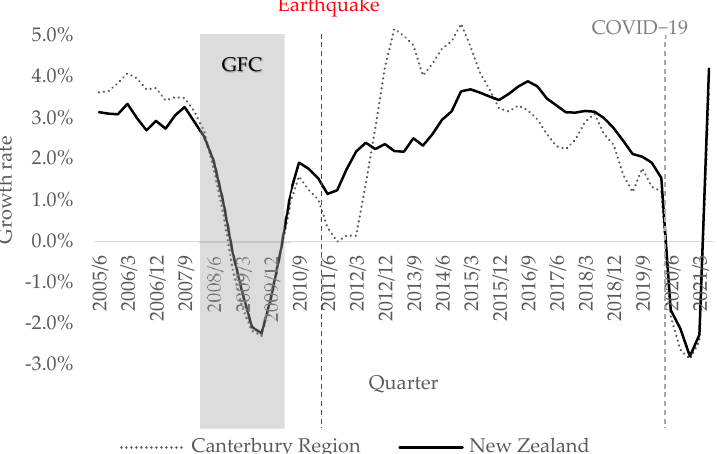
Figure 1. Gross Domestic Product, Average Annual Change, 2005–2021. Source : StatsNZ, Infometrics and author’s calculations.